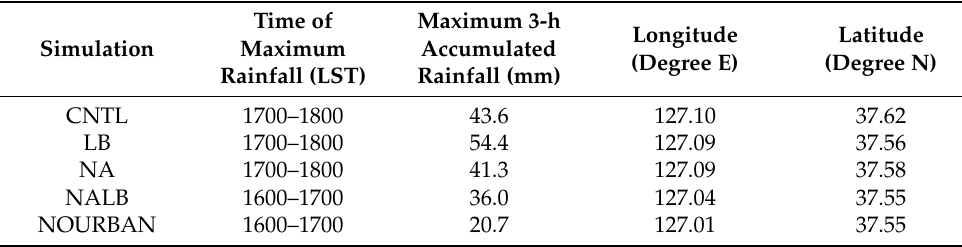
Table 5. Summary of maximum 3-h accumulated rainfall in the analysis domain for the period of 1500–1800 LST in the analysis domain on 6 July 2017.